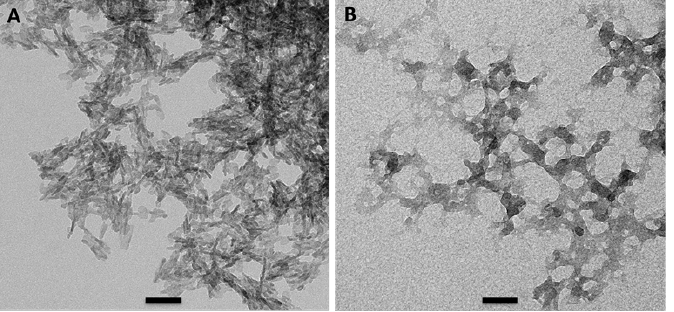
Figure 1. TEM micrographs of Ap-MeJA ( A ) and Nano-MeJA ( B ) nanoparticles. Scale bar = 50 nm.